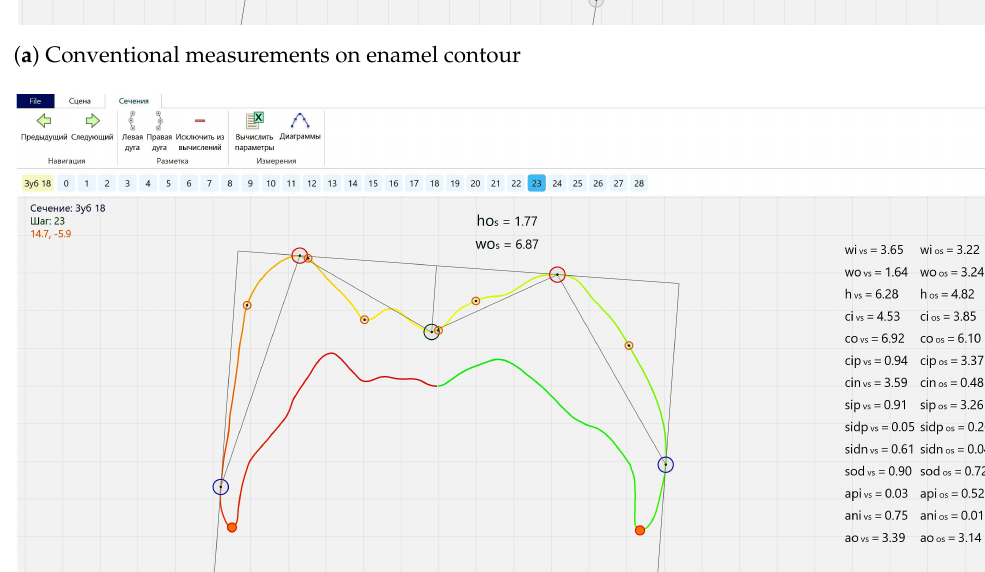
Figure 5. Constructions and landmarks on contours; upper right second molar, S2: conventional measurements on enamel contour ( a ); suggested measurements on enamel cap contour ( b